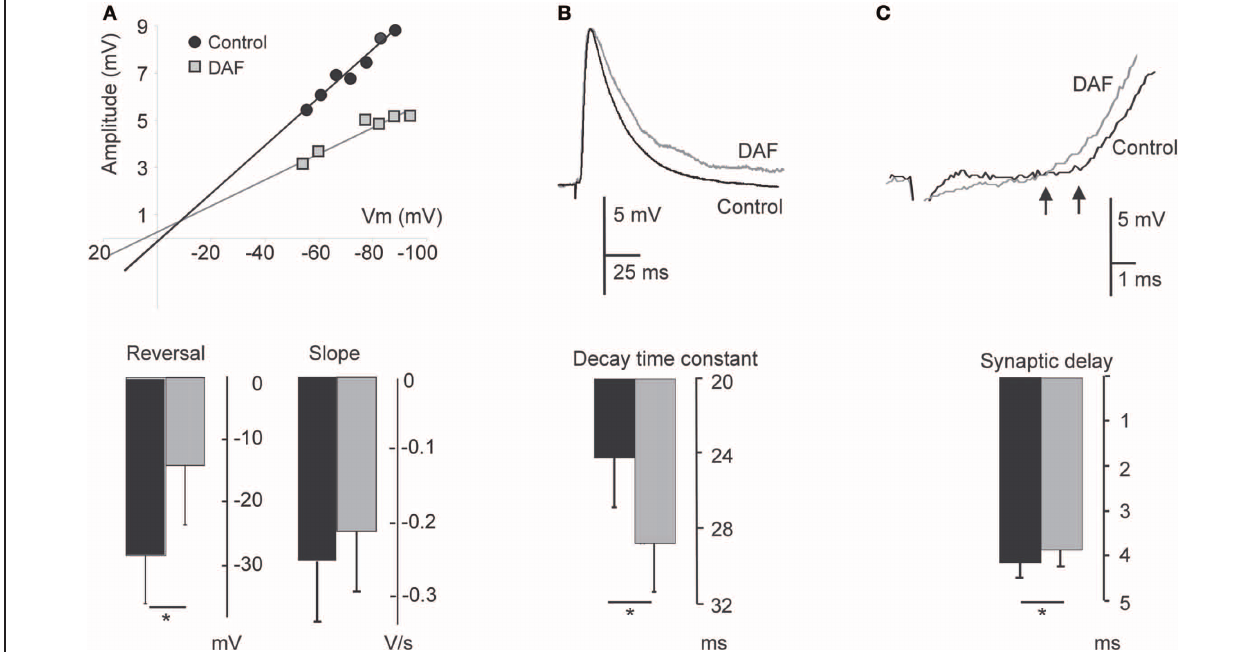
FIGURE 5 | Damage to NOS + interneurons affects synaptic integration in pyramidal neurons. PSPs evoked on layer 5 pyramidal neurons before 2min illumination and afterwards are compared. (A) Plot of the relationship between PSP amplitude and the membrane potential in a single neuron displays a change both in the reversal potential and slope conductance following illumination (upper panel). The bottom panel displays a summary diagram of these parameters for the population ( n = 6). (B) Example traces of EPSPs before and after illumination, demonstrating an elongation of the